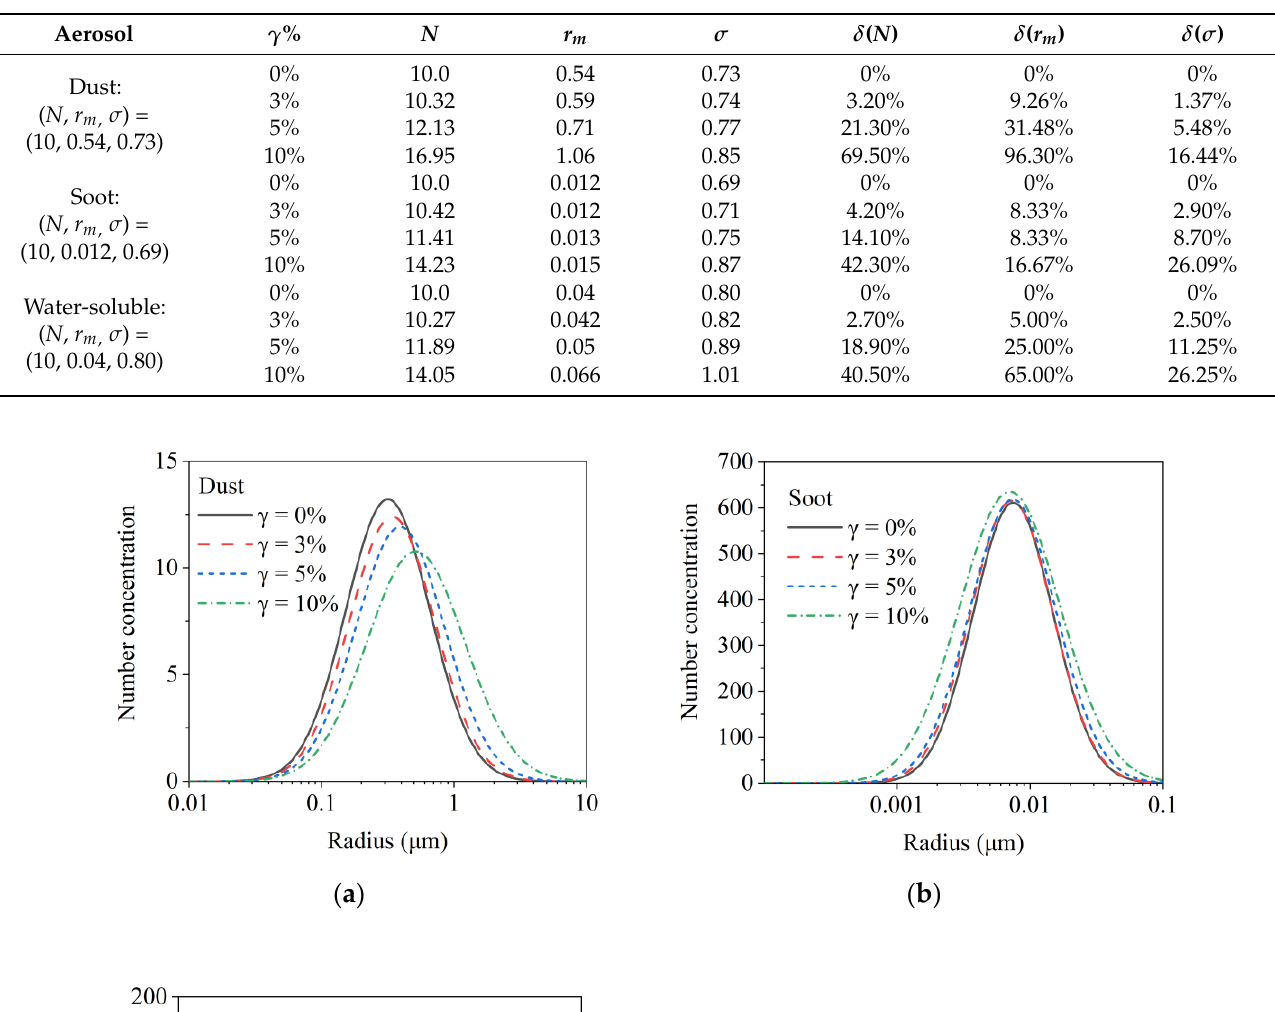
Table 8. The inversion results for three aerosol types.